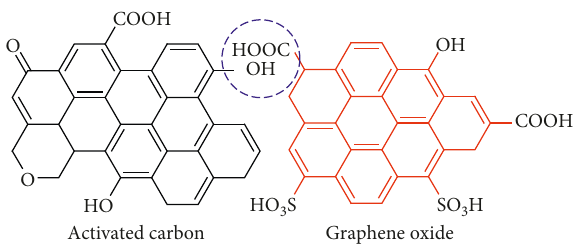
Figure 7: Self-esterification of activated carbon and graphene oxide.